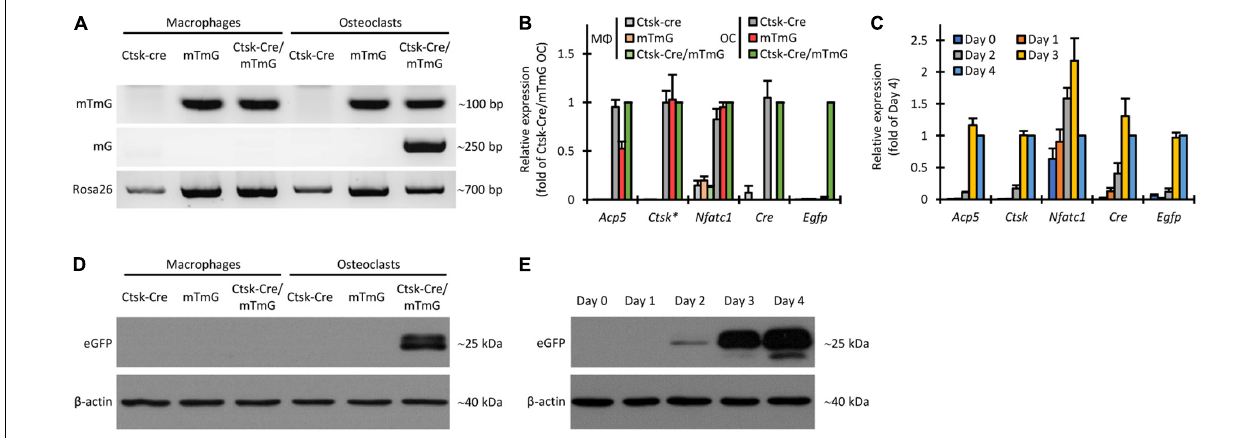
FIGURE 5 | Non-fluorescence-based assessment of Cre-mediated recombination in the FRAMCO1.1 assay. (A) Genomic PCR analysis of the indicated cultures on Day 4 using primers amplifying a target in the loxP-flanked portion of the intact mTmG construct (upper row), primers yielding an approximately 250 bp product from the Cre-recombined (mG) allele (middle row) or with primers amplifying a portion of the Rosa26 locus downstream of the mTmG insertion site (lower row). (B) RT-qPCR analysis of different transcripts on Day 4 in macrophage (M (cid:56) ) or osteoclast (OC) cultures. The asterisk indicates that Ctsk expression values for samples carrying the Ctsk-Cre mutation were multiplied by 2 to compensate for the haploinsufficiency of the wild-type Ctsk allele. All samples were normalized to Ctsk-Cre/mTmG osteoclast values. (C) RT-qPCR analysis of the time course of expression of the indicated genes during differentiation of Ctsk-Cre/mTmG osteoclasts. Data were normalized to Day 4 expression of the respective markers. (D,E) Immunoblot experiments detecting eGFP or β -actin as a loading control from whole-cell lysates of the indicated cultures on Day 4 (D) or of Ctsk-Cre/mTmG osteoclast cultures at the indicated time points (E) . Panels (A,D,E) are representative of 3–5 independent experiments. Panels (B,C) show mean and SEM from 4 to 7 independent